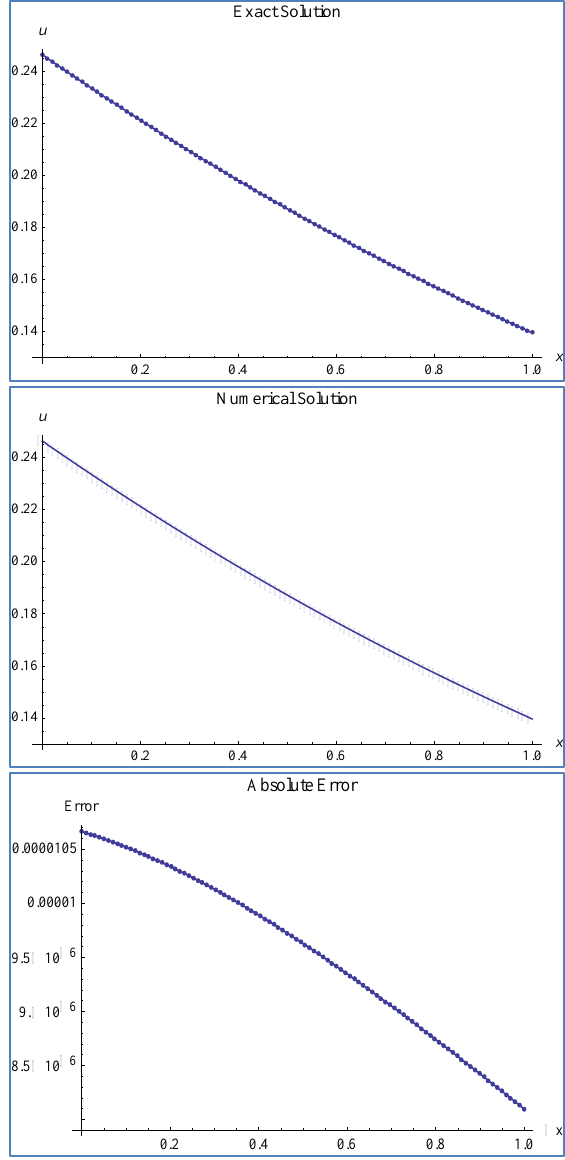
Figure 1. Numerical solution of Eq. (1) for finite difference